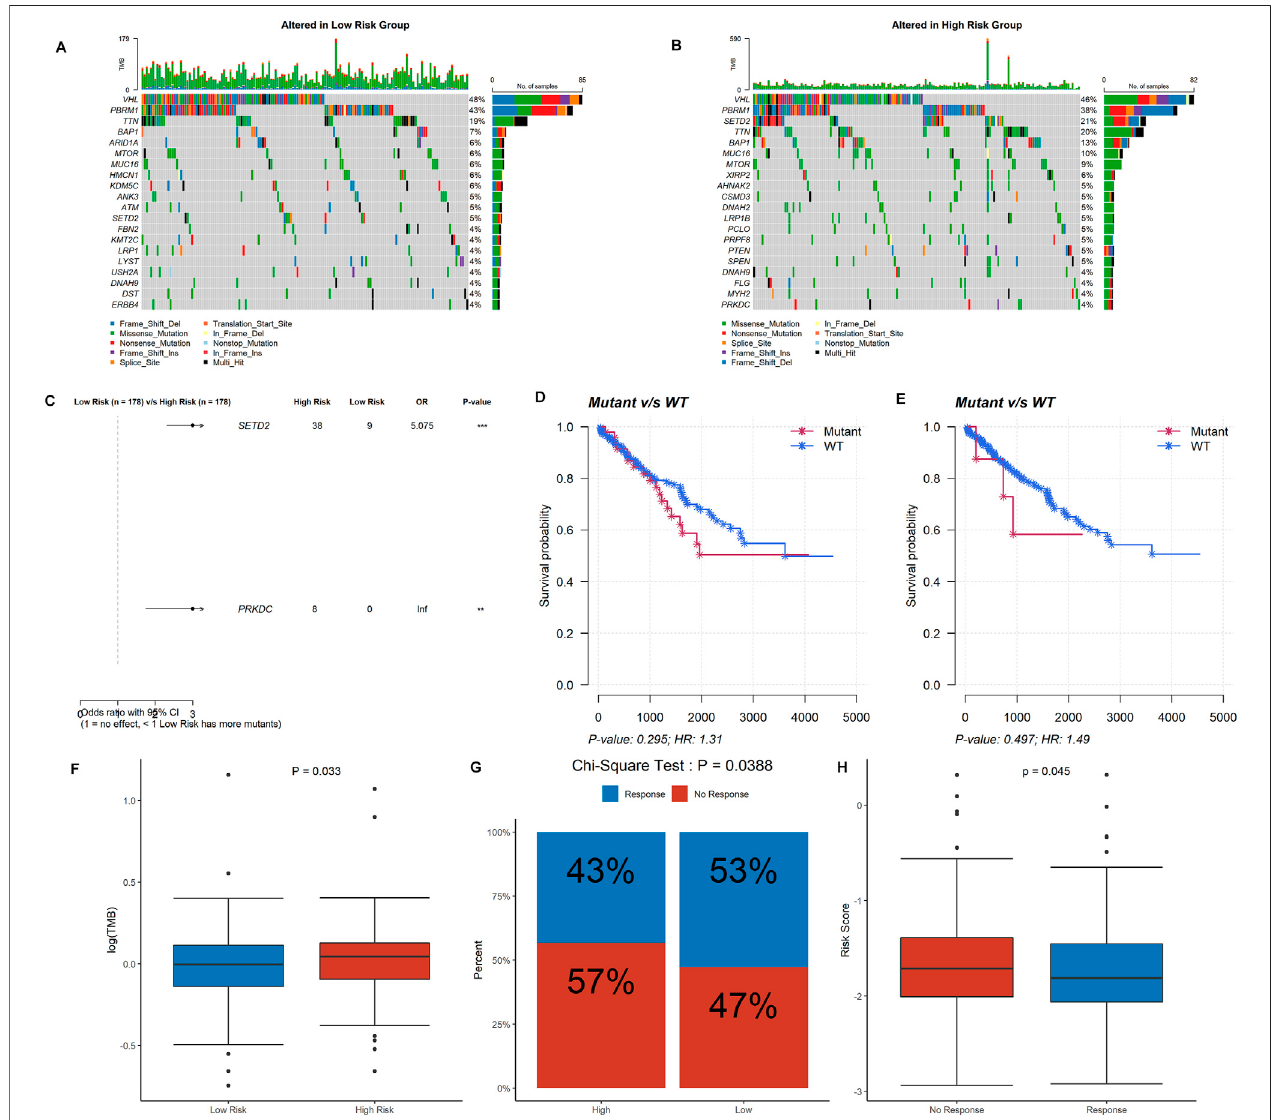
FIGURE 7 | Information of mutation landscape analysis and immunotherapy response. (A,B) The top 20 driver genes with the highest alteration frequency in the low- and high-risk groups, respectively. (C,D,E) Signi fi cant mutation genes between two risk group and their survival analysis in ccRCC patients. (F) Tumor mutational burden between the low- and high-risk groups. (G) Comparison of immunotherapy response in the high- and low-risk groups. (H) Risk score between immunotherapy response group and no response group.